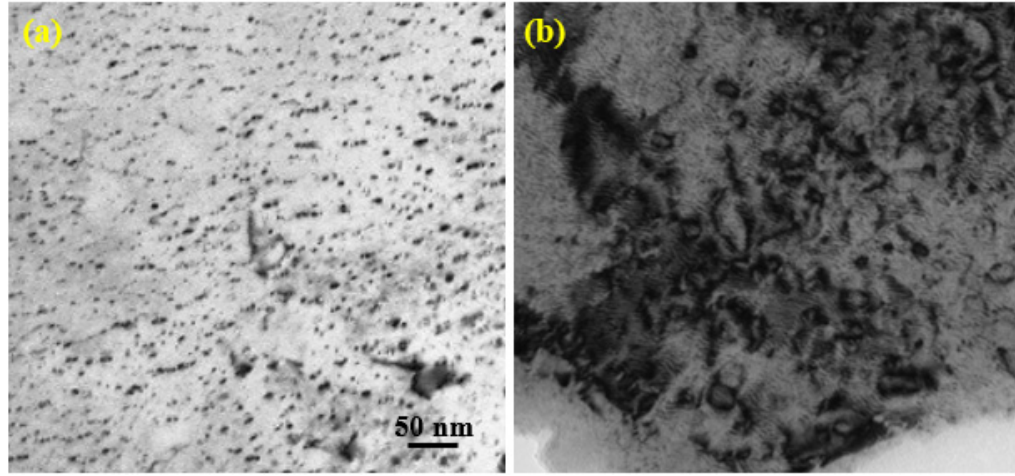
Figure 5. The micrographs of helium/deuterium sequential-ion irradiated Fe9Cr specimens. ( a ) 1 × 10 15 He·cm − 2 /5 × 10 16 D·cm − 2 and ( b ) 1 × 10 16 He·cm − 2 /5 × 10 16 D·cm − 2 .